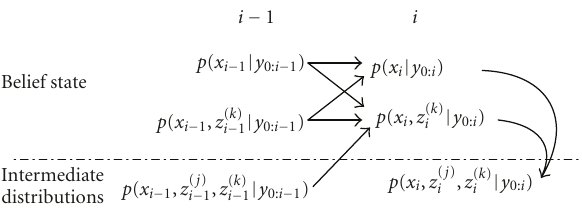
Figure 4: Belief state propagation in forward pass of Approximate inference II. We only need to maintain the belief state the inter- mediate distributions can be calculated based on the independence assumptions when necessary, as indicated by the arrows within each time